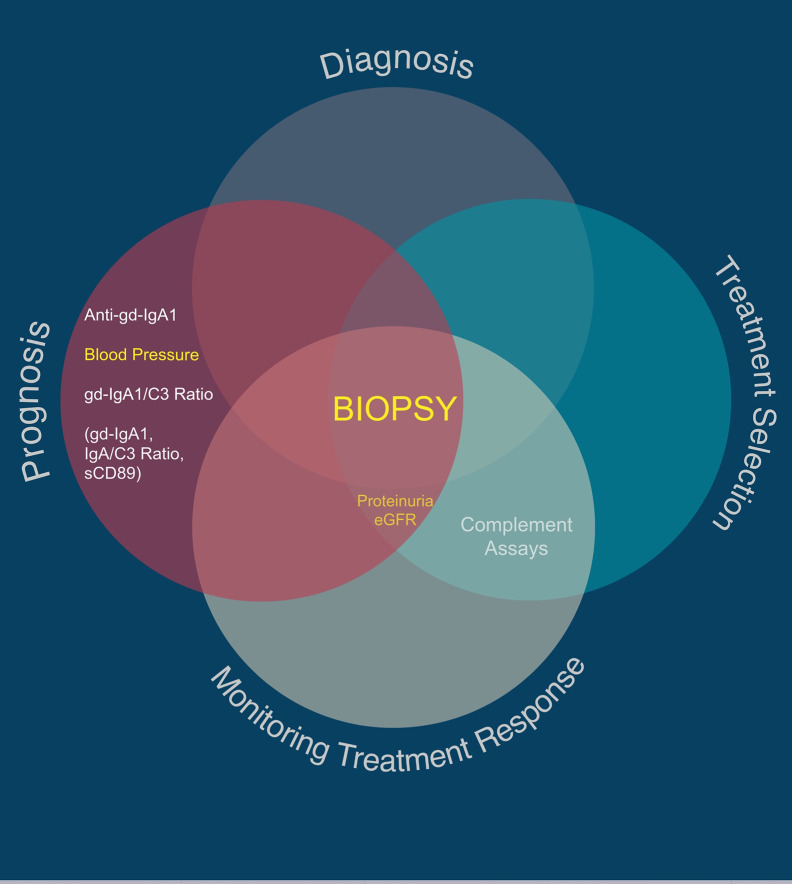
Utility of traditional and suggested utility for novel IgAN-specific biomarkers. Traditional biomarkers are shown in yellow. Proposed novel IgAN-specific biomarkers with the greatest number of associated publications are shown in white, with those in parentheses being regularly reported as useful biomarkers in the literature but with very low quality evidence for sensitivity and specificity in IgAN.